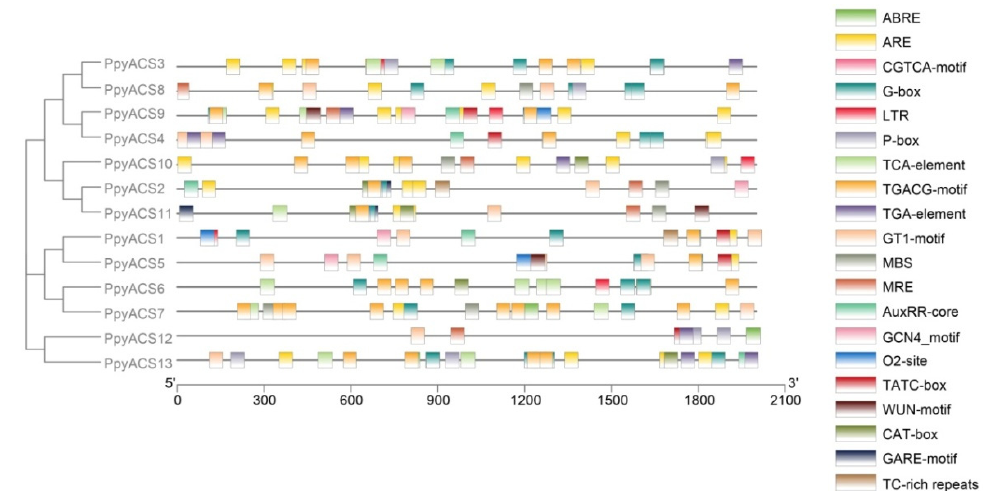
Figure 3. Cis-elements analysis of PpyACS genes. Note: ABRE , abscisic acid-responsive element; ARE , element essential for the anaerobic induction; LTR , low-temperature responsiveness; MBS , MYB binding site involved in drought-inducibility; MRE , MYB binding site involved in light responsiveness; TCA-element , salicylic acid-responsive element; TGA-element, auxin-responsive element; TC-rich repeats , defense and stress responsiveness; TGACG- and CGTCA-motif , MeJA responsiveness; GARE-motif , gibberellin-responsive element; TATC-box , gibberellin-responsive element; WUN-motif , wound-responsive element; P-box , gibberellin-responsive element; AuxRR-core , auxin-responsive element.